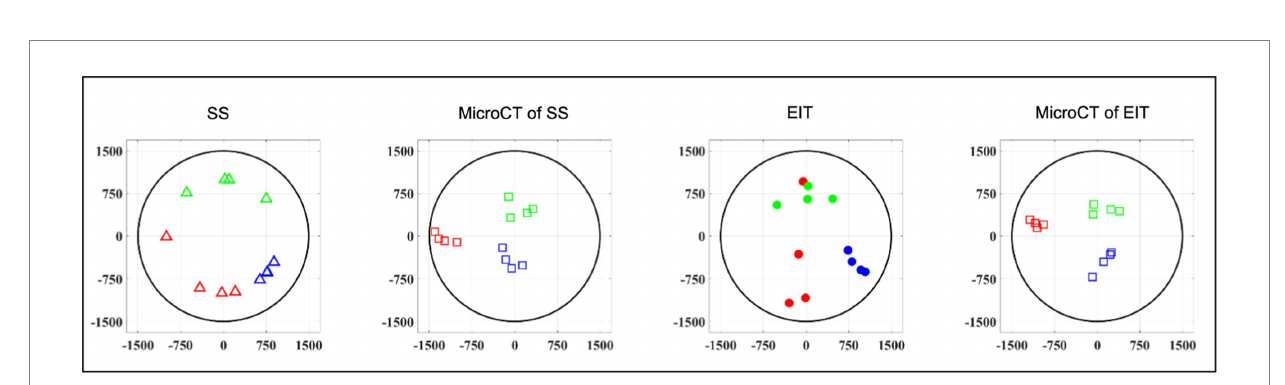
FIGURE 6 Clustered CoMs of the fascicular groups of each nerve for each technique rotated with respect to the laryngeal fascicles ( N = 4; laryngeal in green, pulmonary in blue and cardiac in red). CoM location identified by each technique, respectively, is reported over a circular cross-section with 3 mm diameter, expressed in figure as ±1,500 μ m on both